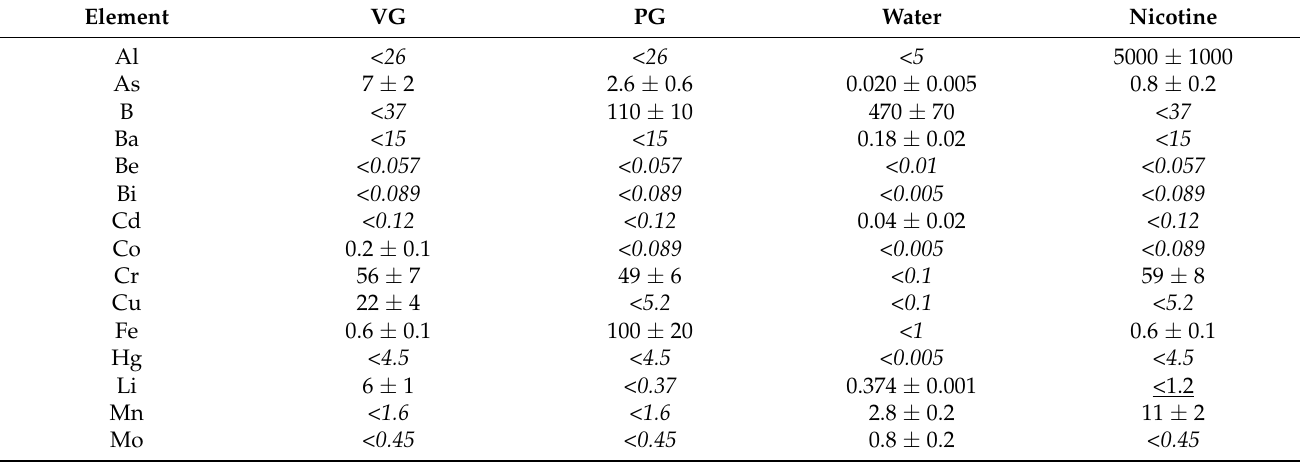
Table 5. Mean amounts (in μ g kg − 1 ± SD) of 23 toxic elements and oligoelements in VG, PG, water, and nicotine used for the preparation of the e-liquids. n = 3.